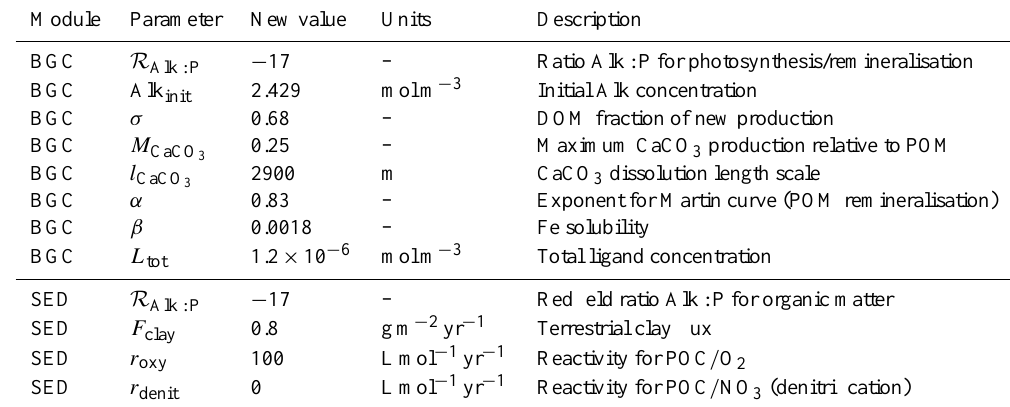
Table A2. Overview of updated parameters in the 41 × 40 setup of the ocean biogeochemistry (BGC) and sediment (SED) modules w.r.t. Tschumi et al.